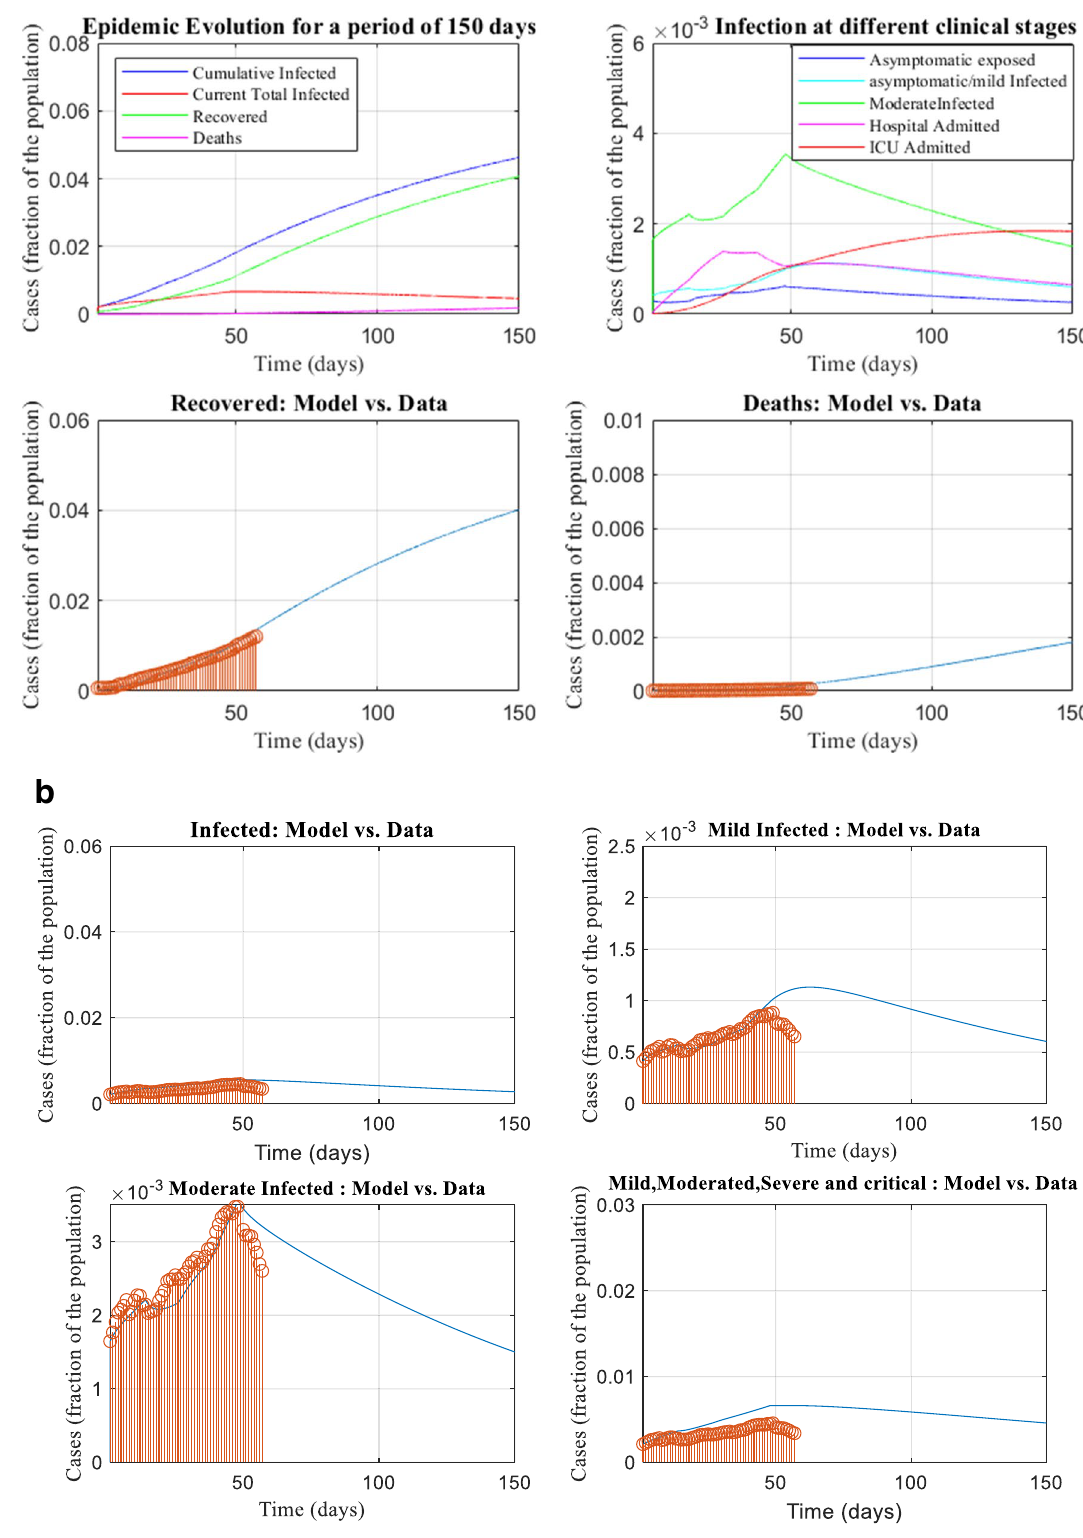
Figure 6. ( a ) The pandemic size of different clinical stage versus time—infected case, the recovered case and death case. ( b ) The pandemic size of different clinical stage versus time—mild, moderate and all the cases